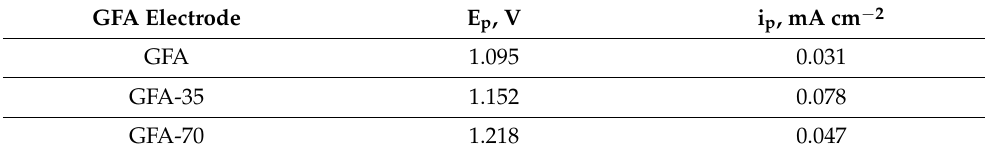
Table 7. Comparison of E p and i p values for electrooxidation of 4-CP on GFA